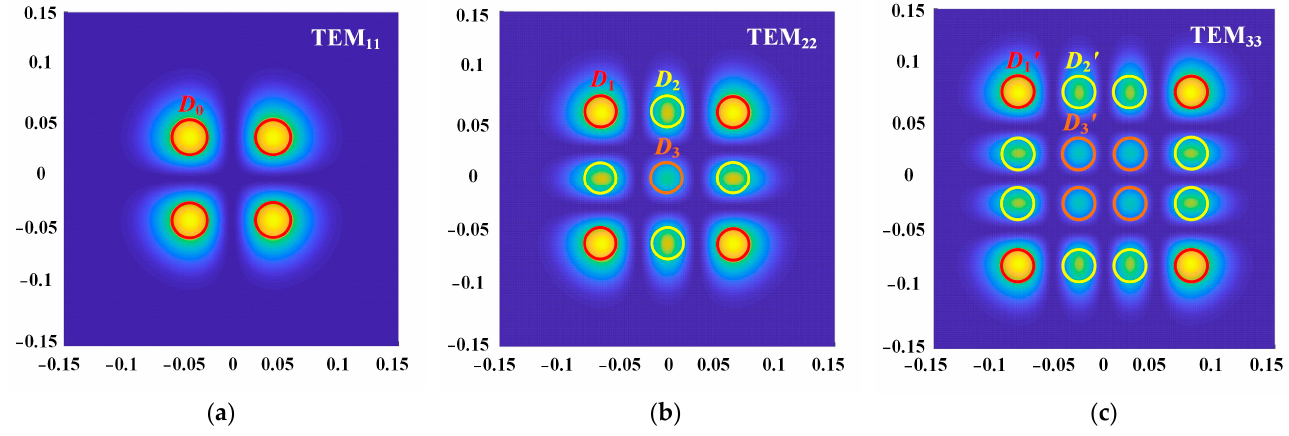
Figure 7c). Taking the TEM 33 HG beam as an example, the receiving apertures are the same but are divided into three groups according to the peak irradiance (red, yellow and or- ange), and the average received power values of similar color receiving apertures are equal.